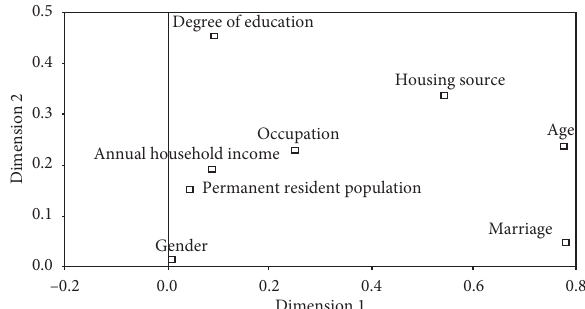
Figure 1: Distinguishing measure map of multivariate correspondence